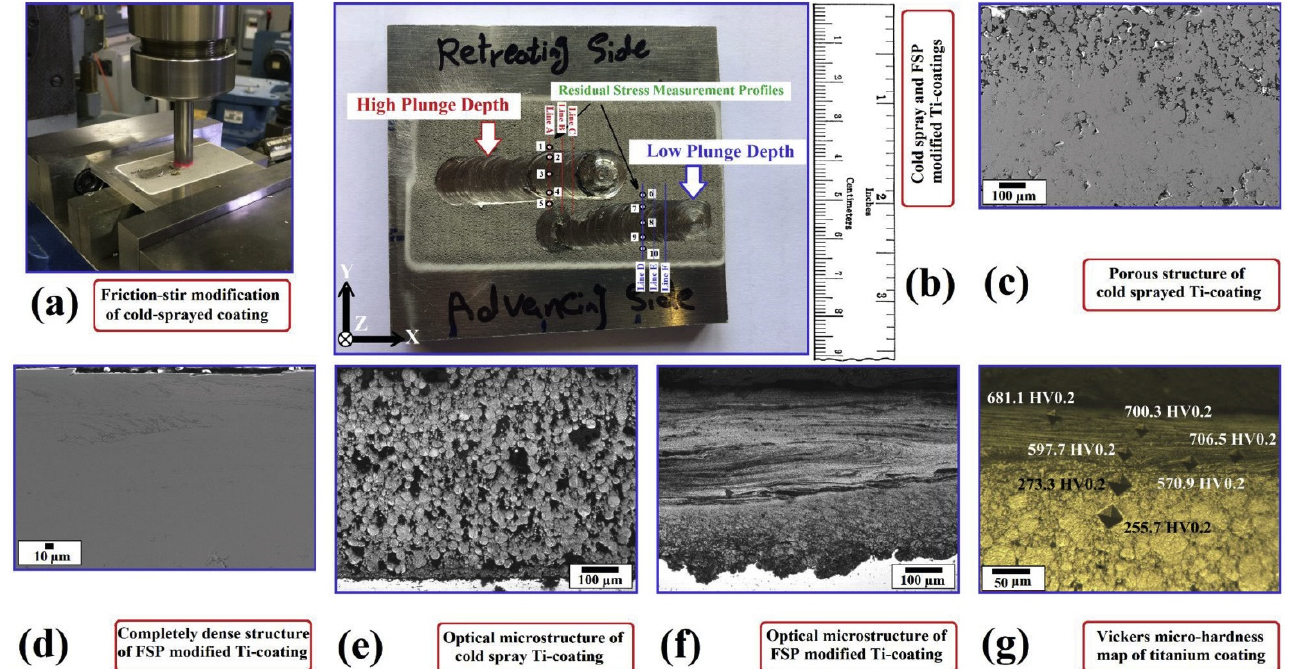
Figure 19. Schematic implementation of FSP on the surface of CS titanium coating ( a ), top-view macro-image from the prepared coating layers after two-steps cold gas spraying and friction-stirring showing the measurement profiles for residual stress ( b ), FE-SEM images ( c , d ) and optical microstructures ( e , f ) from the porous CS sprayed titanium ( d , f ) coating and ( d , f ) friction-stirred one, respectively, indentation Vickers micro-hardness profile close to the surface of produced modified coating layer ( g ). Reprinted with permission from [199]. Copyright 2019 Elsevier.